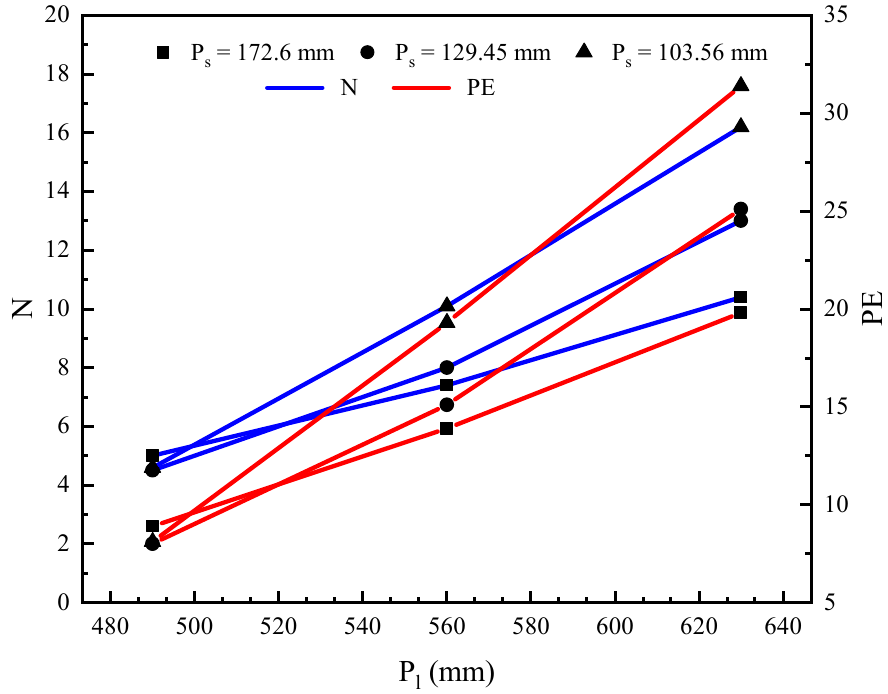
Figure 7. Plot of the effect of pole plate height on Pe number, model parameter N. Table 3. Pe number and model parameter N.